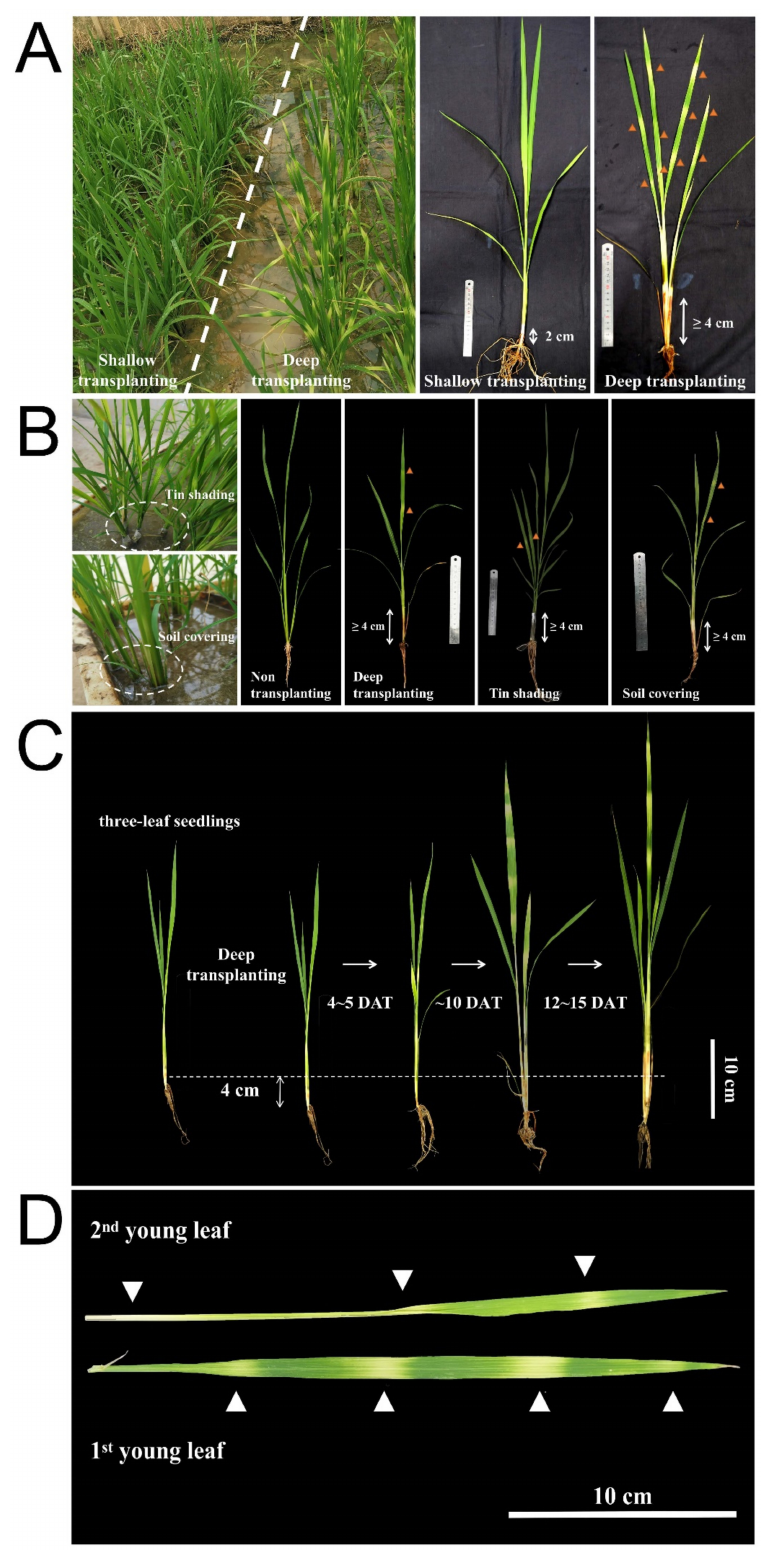
Figure 1. Phenotype of obvious striped leaves occurred in B03S under different treatments. ( A ) Deep/shallow transplanting plants in the field. ( B ) Soil covering and aluminum shading plants in pots. ( C ) The zebra stripes of leaves occurred under deep transplanting. ( D ) The obvious yellow- green stripes varied in different leaves of an individual plant at the same growth periods. Triangle symbols indicate significant the yellow stripes in leaves. DAT, day after